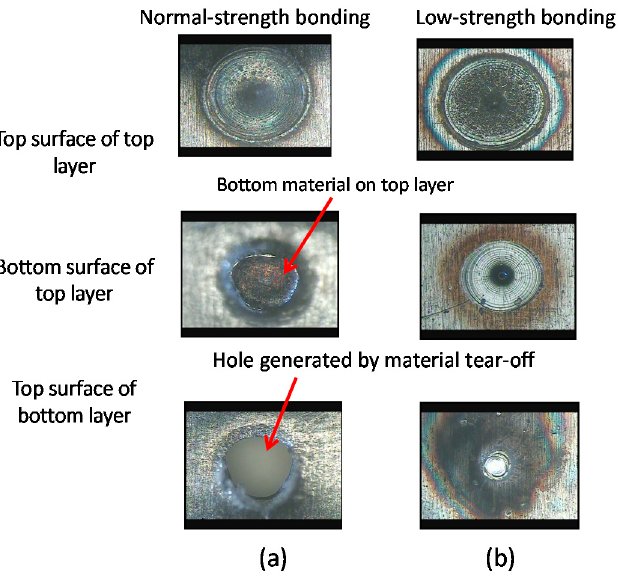
Figure 5. Surface condition of samples after peeling: ( a ) high and ( b ) low joint strength [22].